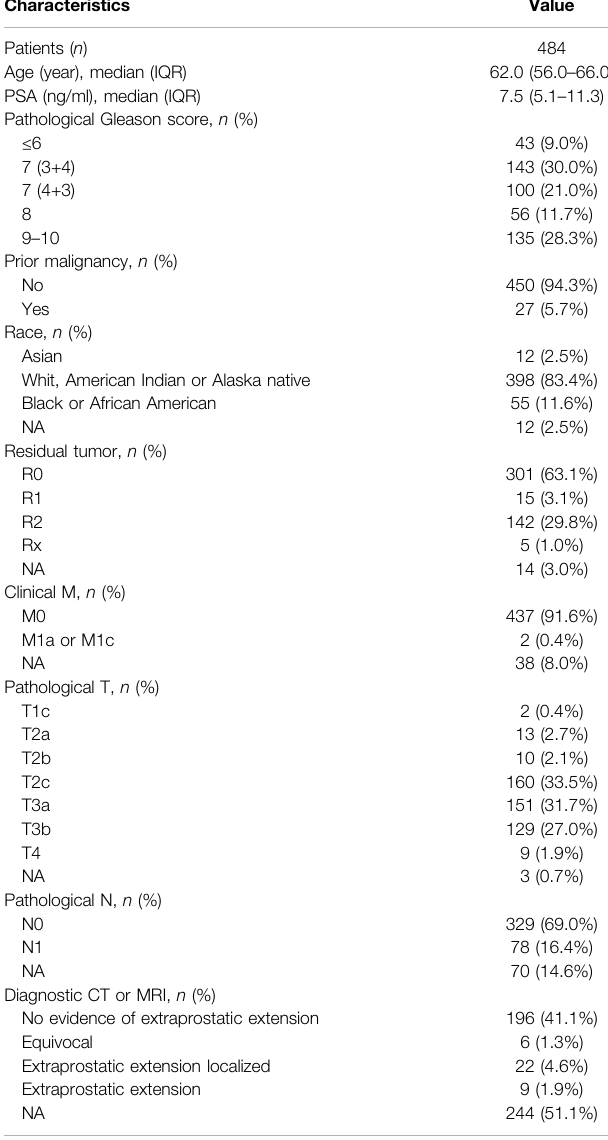
TABLE 1| Thedisease-relatedclinicalinformationofpatientswithPCaincludedin the study.